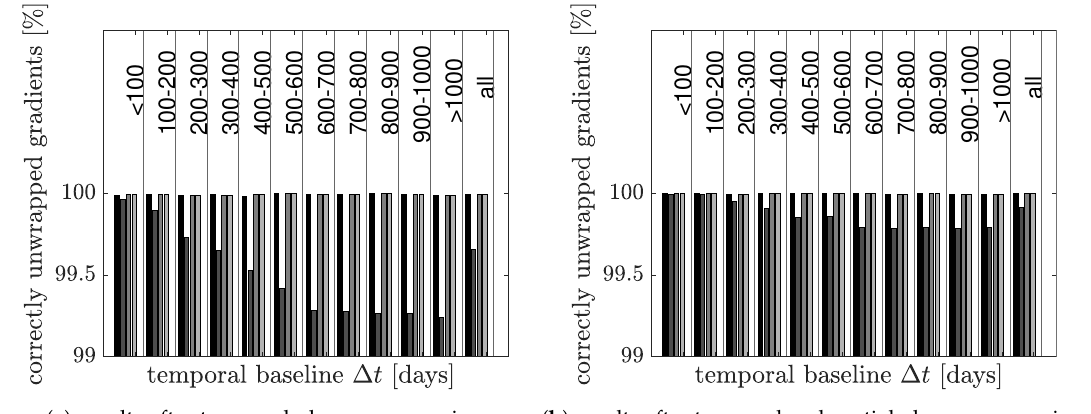
Figure 9. Percentage of correctly unwrapped phase gradients depending on the temporal baseline. The motion model is estimated with different approaches. The black bars show the results of the conventional way by minimizing the costs of the temporal LP in an iterative search process. The dark gray bars show the results using the Nelder–Mead method to estimate the motion model by maximizing the EPC, the middle gray bars when using the grid search method and the light gray bars when using simulated